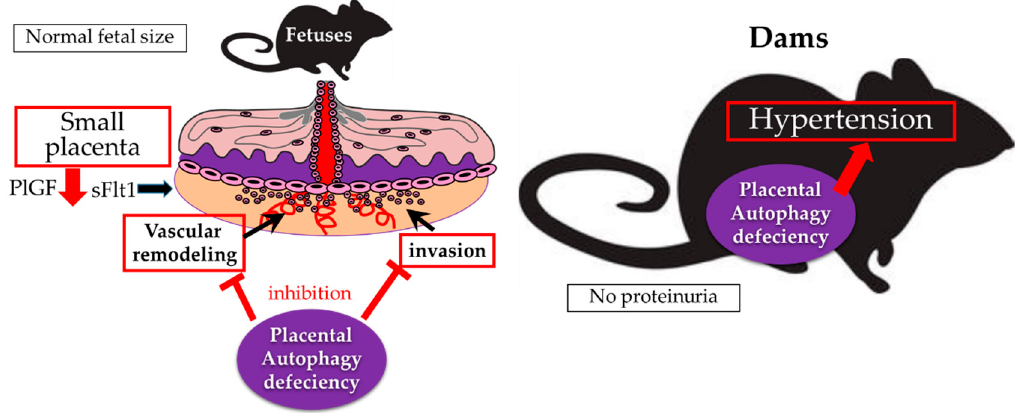
Figure 2. Placental autophagy inhibition inducing gestational hypertension and poor placentation. (Left figure) Trophoblast-invasion and vascular remodeling are fundamental for normal placentation (the black arrows indicate the place of invasion and vascular remodeling). Autophagy deficiency impairs the functions of trophoblasts in the trophoblast-specific Atg7 knockout mouse model, resulting in poor placentation (the red “T” bars indicate the inhibition). PlGF mRNA levels, but not sFlt1 mRNA levels, are decreased in the knockout placentas (the red arrow indicates the decrease, and the black arrow indicates the stable). (Right figure) Also, the dams bearing the knockout placentas showed hypertension, but not proteinuria (the red arrow indicates the induction of hypertension by the placenta).